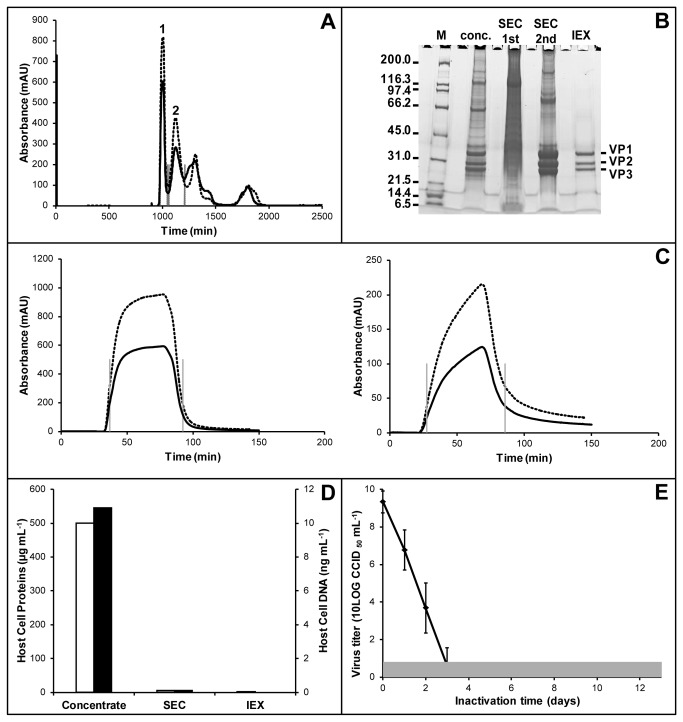
Purification of Sabin PV.Panel A depicts a SEC chromatogram of Sabin PV type 1. The 1st peak contained mostly large cell components; the 2nd peak contained the majority of PV, following peaks consist of smaller components. Panel B shows a SDS-PAGE (4-20% gel); lanes represent (from left to right) the marker, the concentrated product, followed by the 1st and 2nd fraction of SEC and finally the IEX purified PV. Panel C shows chromatograms of Sabin PV type 1 (left) and Sabin PV type 2 (right) IEX purification. Panel D shows host cell protein (open) and DNA (solid) impurities. Panel E depicts the inactivation of PV, the gray area indicates the lower detection limit. In chromatograms A and C, the dotted and solid lines represent absorbance at respectively 254nm and 280nm. Gray dotted lines indicate peak fractioning.